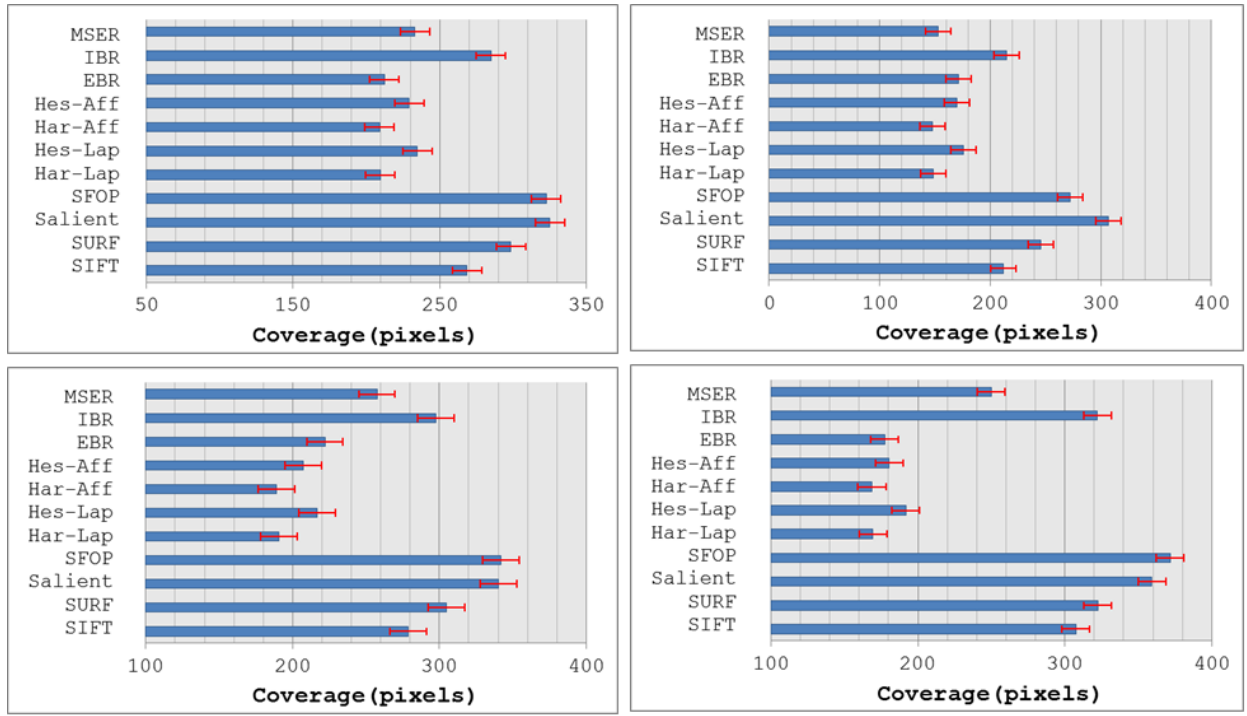
Figure 8. Coverage results for Snow ( top left ), Indoor ( top right ), Campus-1 ( bottom left ) and Campus-2 ( bottom right ) datasets [24]; the error bars indicate the 95% confidence intervals for mean